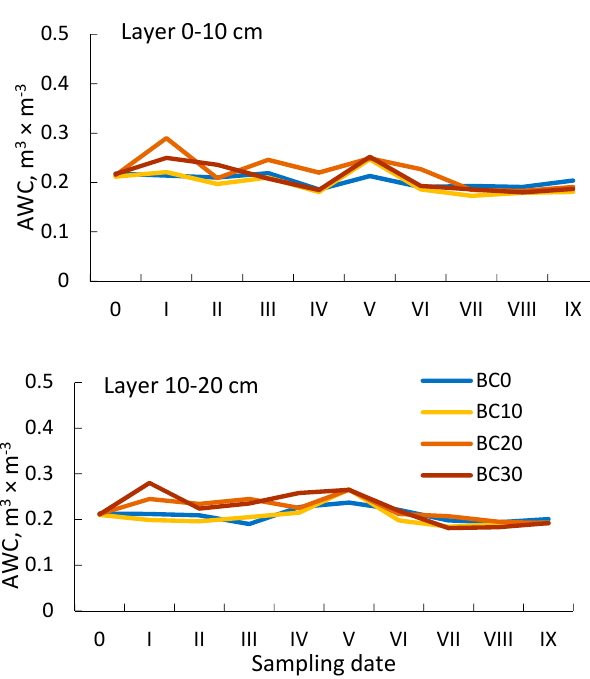
Figure 8. Available water content (AWC). Explanations as for Figure 1.